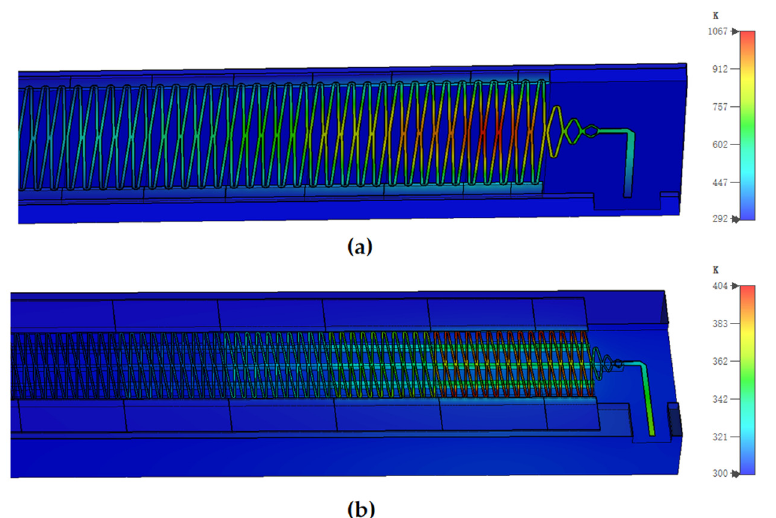
Figure 13. The maximum temperature distribution in the ( a ) DS-RSML SWS and ( b ) MDSRL-RSML SWS.